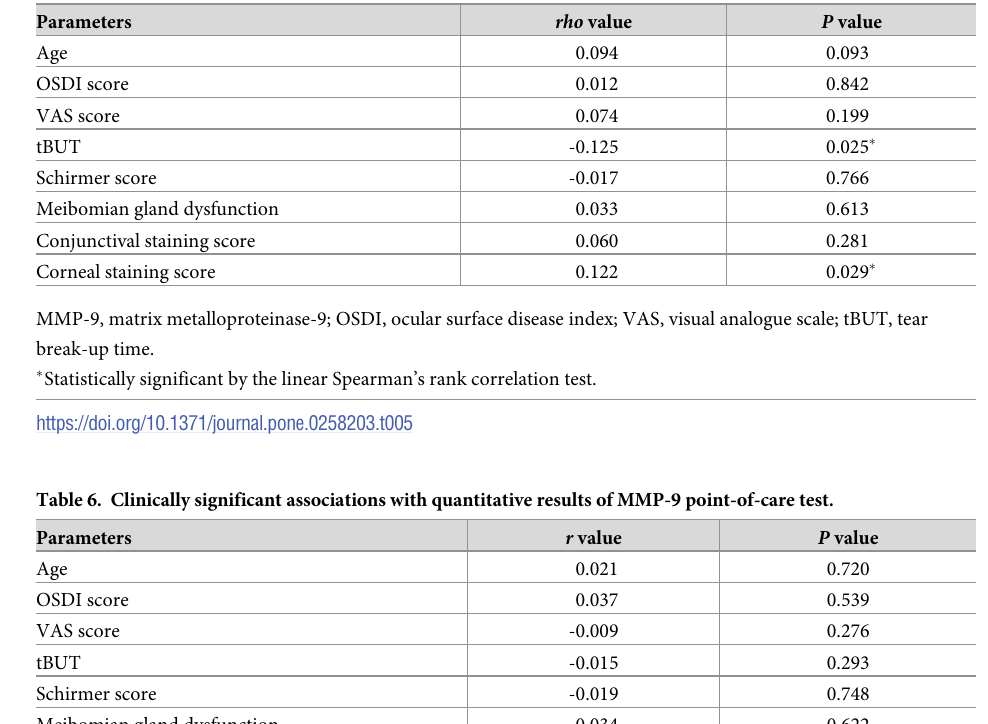
Conjunctival staining score 0.021 0.720 Corneal staining score 0.113 0.052 MMP-9, matrix metalloproteinase-9; OSDI, ocular surface disease index; VAS, visual analogue scale; tBUT, tear break-up